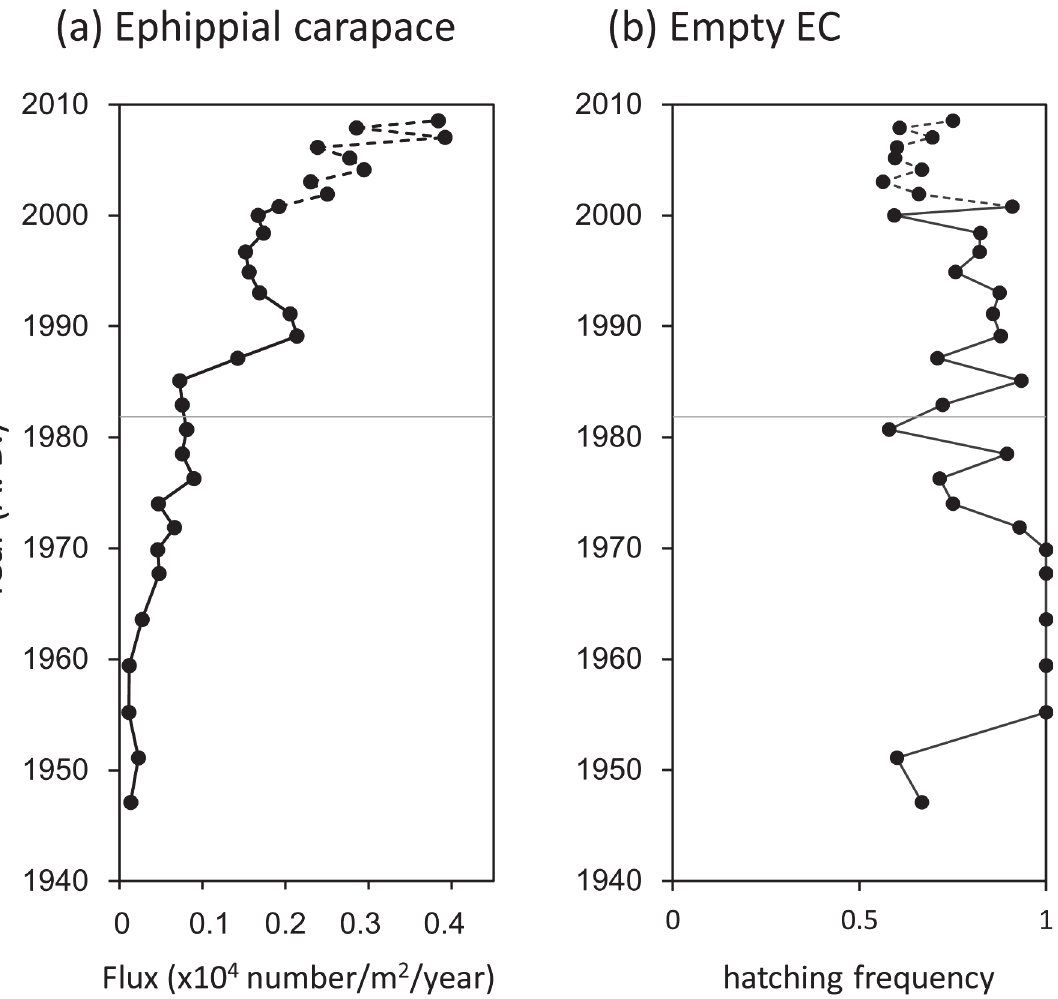
Fig 7. Ephippial carapace fluxes of Daphnia (a), and frequency of empty ephippial carapaces (b). Open circles indicate zero values. Fluxes of inaccurately estimated chronological years are denoted by broken lines. Two distinct periods (I and II) from the cluster analysis in Fig. 4 are divided by a thin